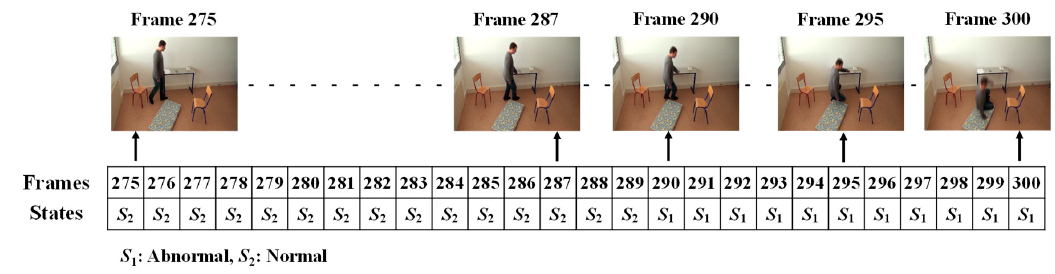
Figure 8. Observed sequence of the occurrences of states.